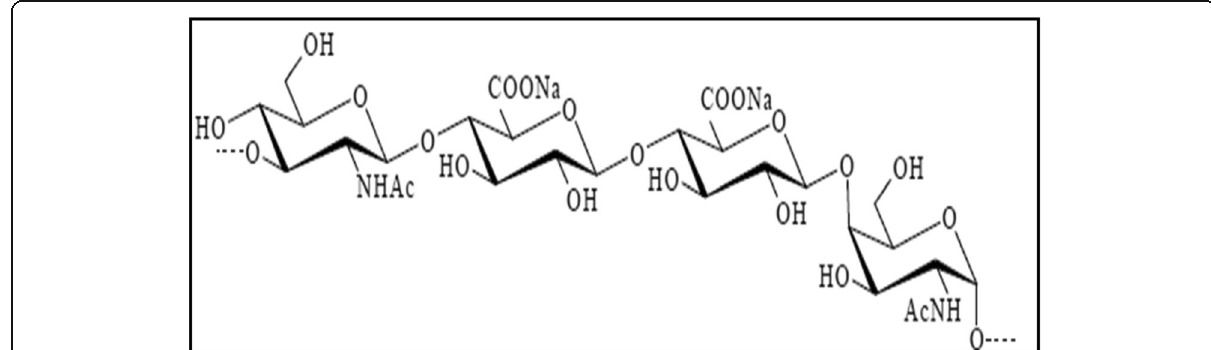
Fig. 1 Repeating unit of the marine bacterial polysaccharide (HE800 EPS) produced by Vibrio